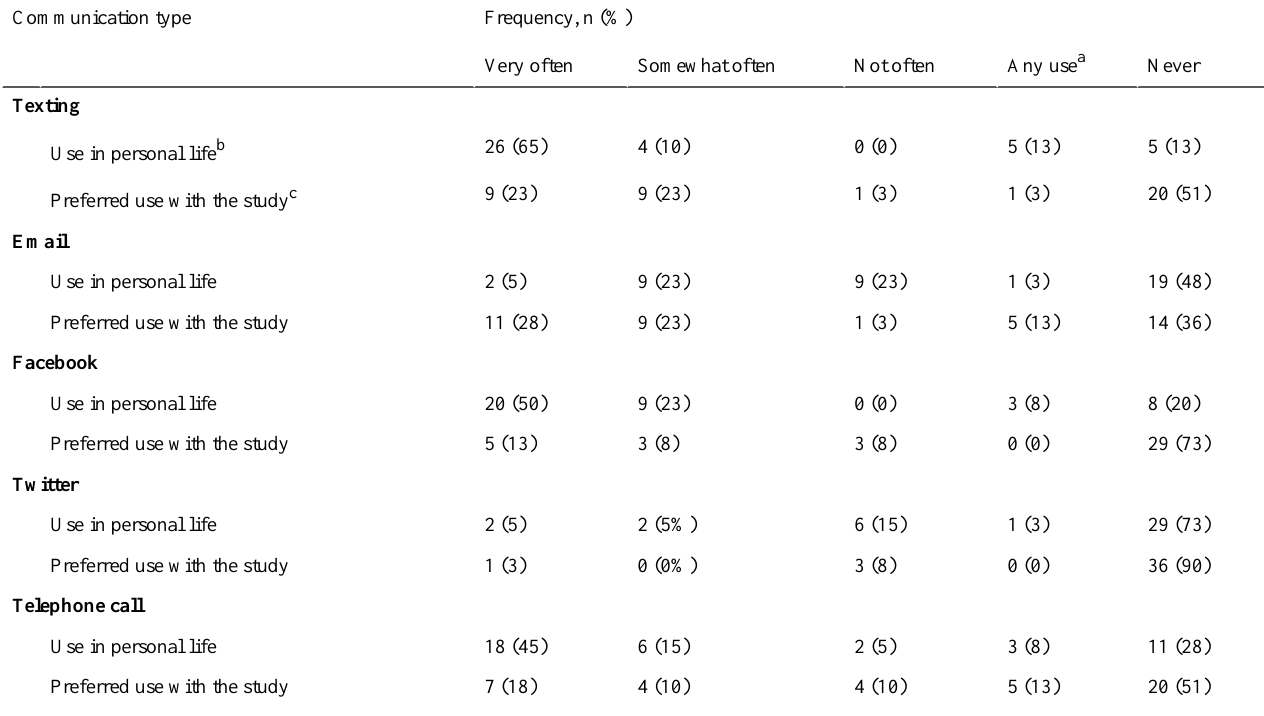
Table 3. Communication preferences of young adults in PHACS in personal life vs in pediatric HIV research (N=40).